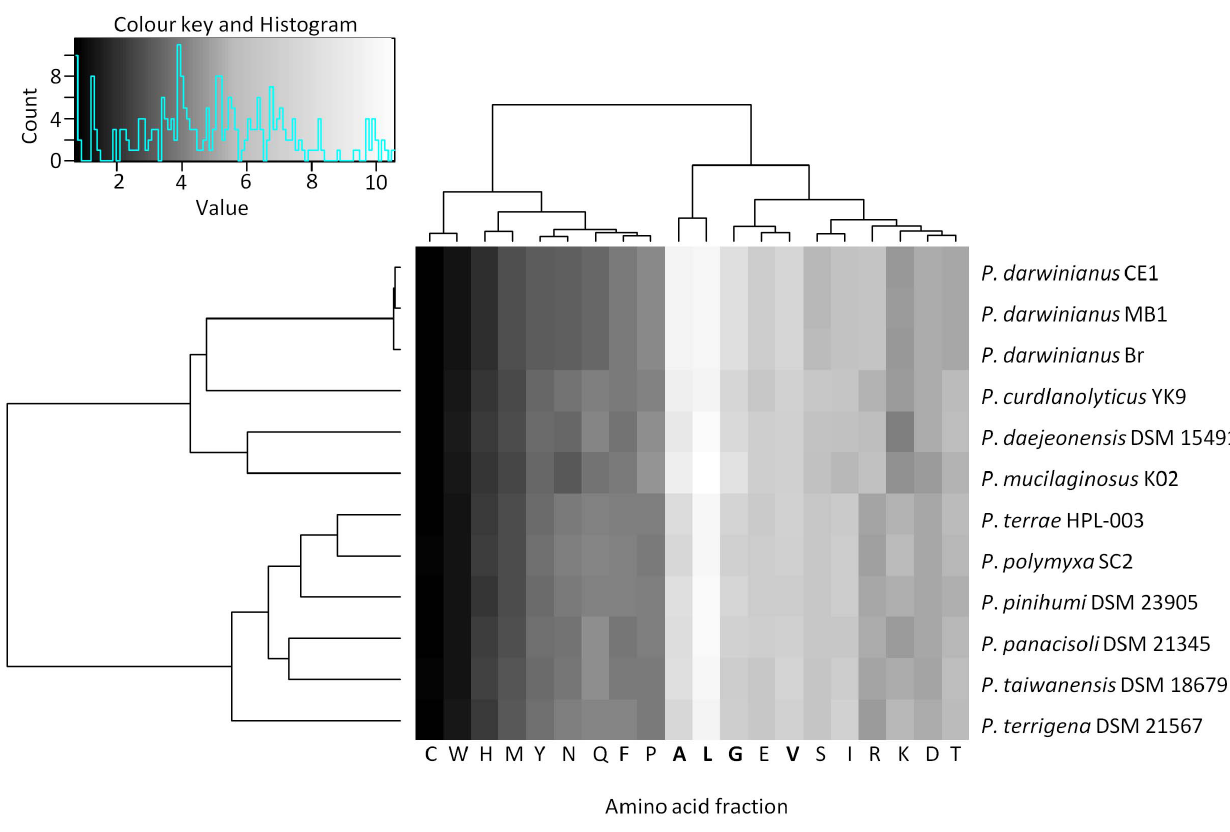
Figure 2. Amino acid usage heatmap of temperate Paenibacillus spp. and P.darwinianus strains.